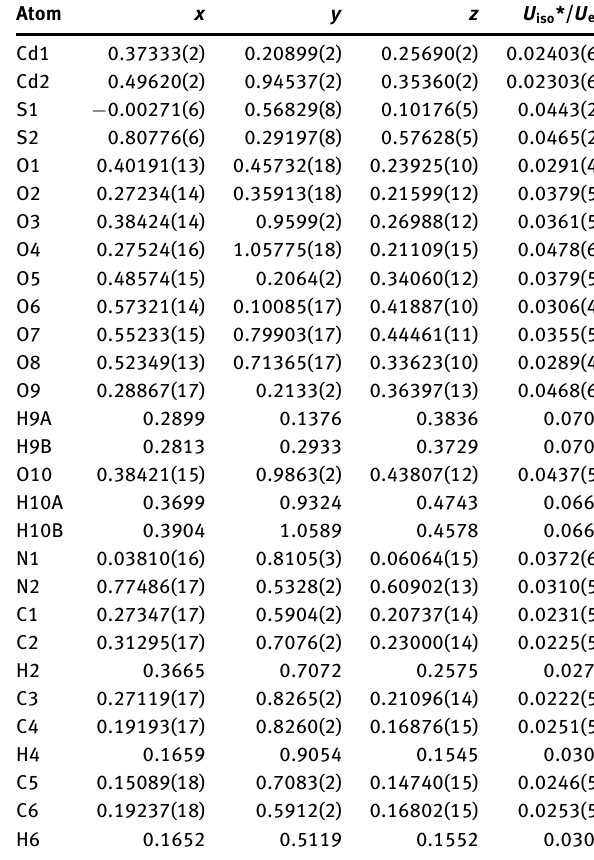
Table 2: Fractional atomic coordinates and isotropic or equivalent isotropic displacement parameters (Å 2